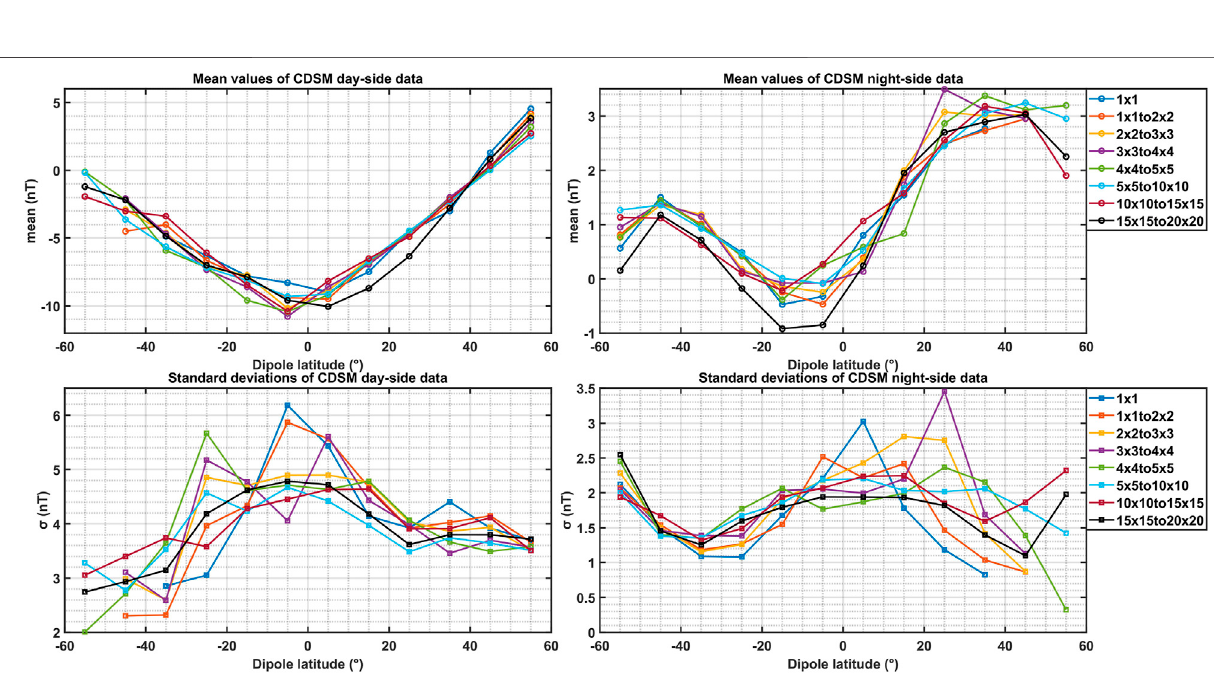
Frontiers in Earth Science |